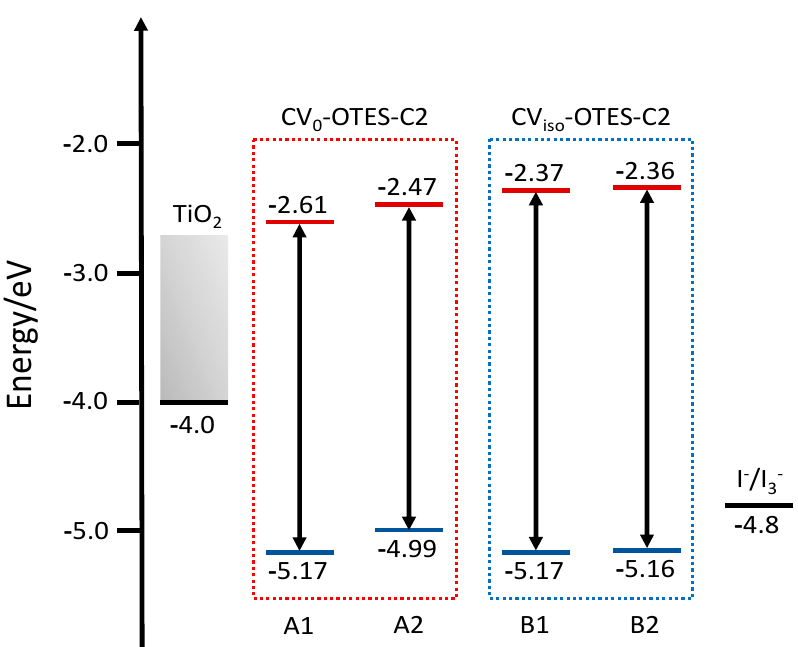
Figure 6. Calculated energy levels of the HOMOs (blue lines) and LUMOs (red lines) for CV 0 –OTES–C2 and CV iso –OTES–C2 using CPCM in EtOH.